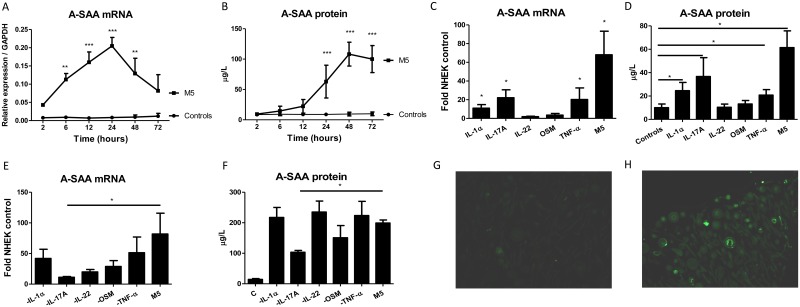
A-SAA production by NHEK stimulated with human IL-1α, IL-17A, IL-22, OSM, TNF-α, alone or in combination.(A) A-SAA mRNA expression and (B) protein secretion by NHEK stimulated with M5 were analyzed at different time-periods. (C) A-SAA mRNA expression and (D) protein secretion were determined 40 hours after cytokine activation. (E) A-SAA mRNA expression and (F) protein secretion by NHEK 40 hours after stimulation with four cytokines by sequentially subtracting either recombinant IL-1α, IL-17A, IL-22, OSM or TNF-α from M5. A-SAA mRNA and protein were quantified by RT-qPCR in NHEK and ELISA in supernatants, respectively. Data represent the mean ± SEM of three experiments with duplicates. Statistical comparisons were performed using 2way ANOVA test or t test (*p<0.05; **p<0.01; ***p<0.001). (G) Compared to resting control, (H) intracellular A-SAA staining was detected by immunofluorescence in the cytoplasm of NHEK stimulated with M5 in the presence of brefeldin A.